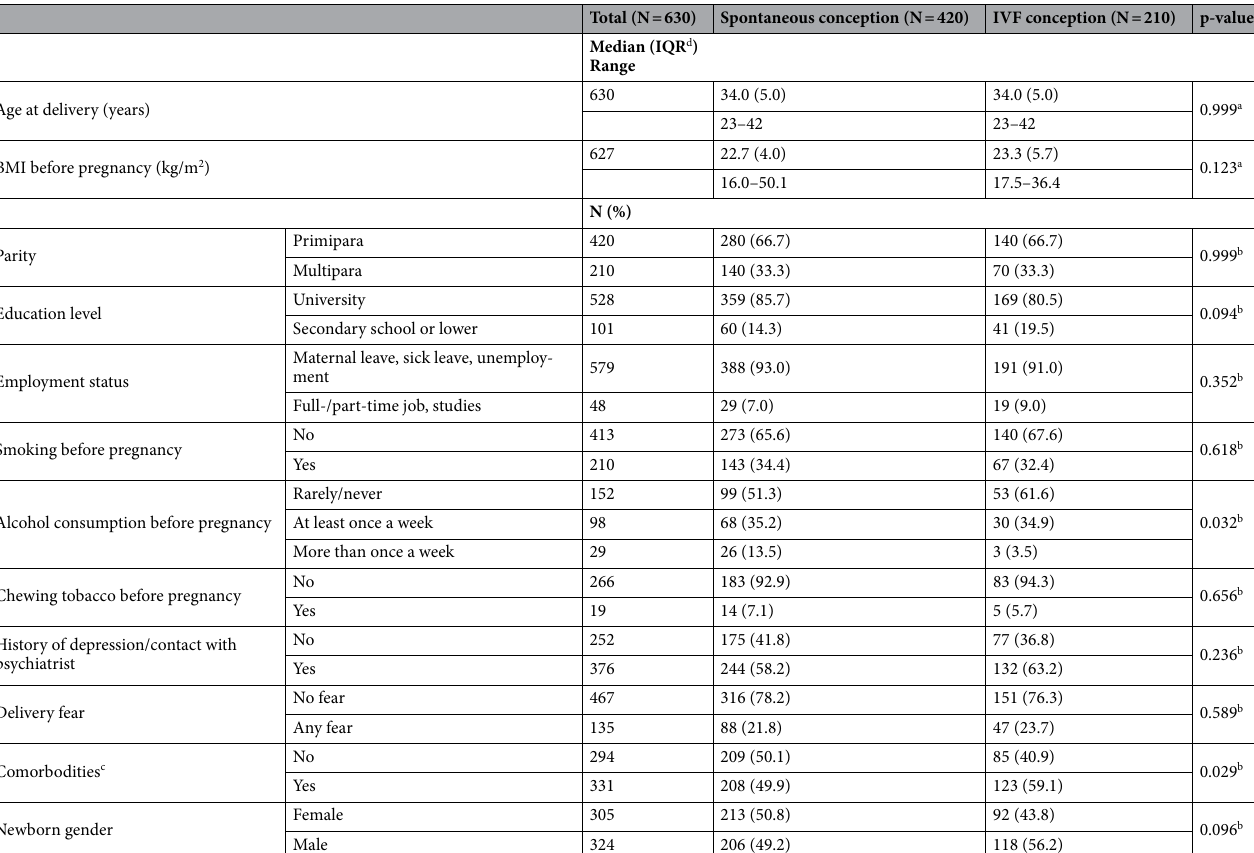
Table 1. Sociodemographic and pregnancy-related characteristics in IVF pregnancies and matched spontaneous conceptions. a Mann–Whitney U-test. b Chi-square test. c Comorbidities include migraine, hypertension, diabetes, metabolic disease, allergy, irritable bowel syndrome, alcohol/drug addiction, chronic pain or other disease. d Interquartile